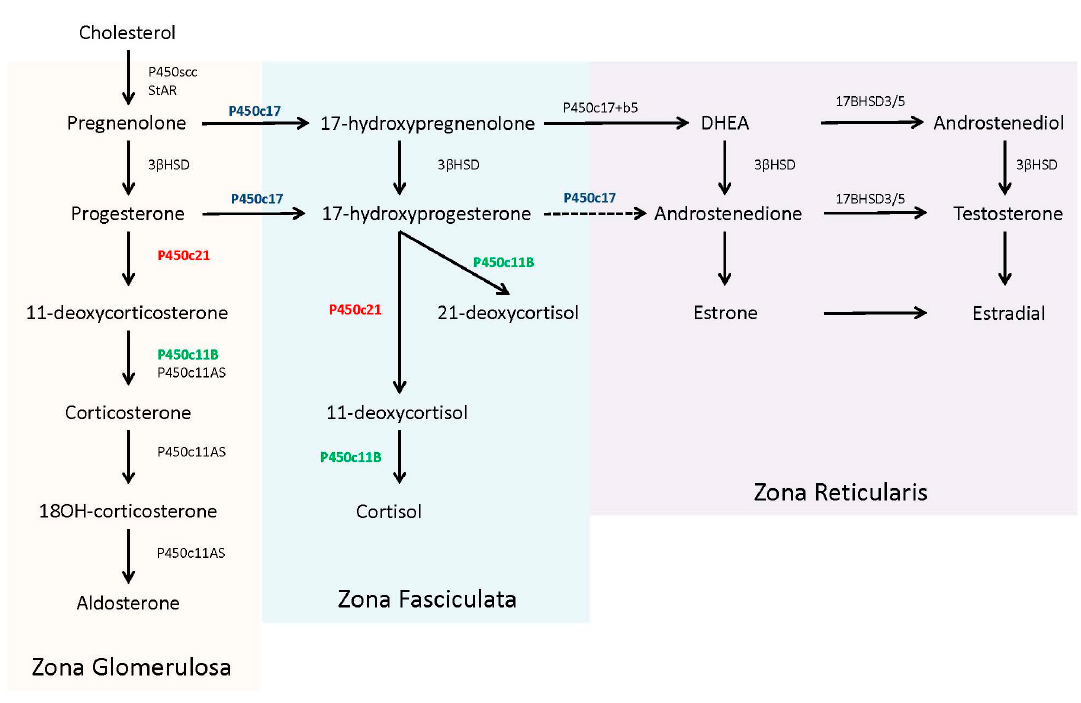
Figure 1. Adrenal steroidogenesis pathway. Biosynthetic pathway of mineralocorticoids (aldosterone), glucocorticoids (cortisol), and sex hormones (testosterone) within the adrenal. Partitioning for synthesis of key steroids occurring within each of the three zones (zonal glomerulosa, zona fasciculate, and zona reticularis) is provided in the shaded areas. Dashed lines with arrow heads, as compared to solid lines, denotes enzyme steps have limited affinity for conversion of the substrate to the product. DHEA = dehydroepiandrosterone, 3 β HSD = 3 β -hydroxysteroid dehydrogenase.